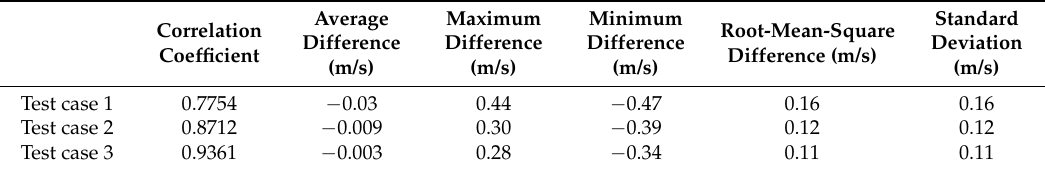
Table 1. Comparison of results between the true velocity data sequence and the predicted velocity data sequence.